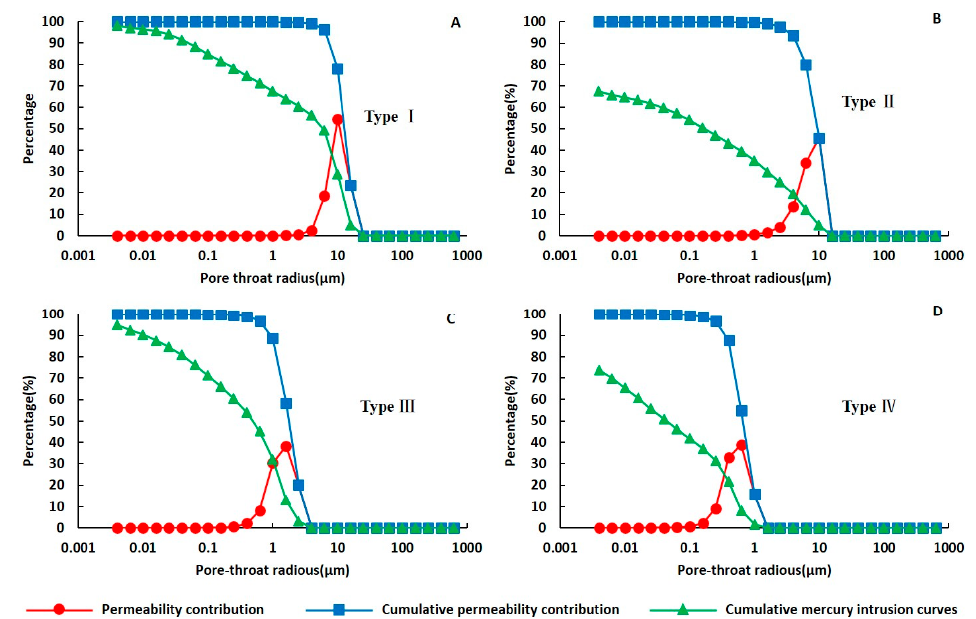
Figure 7. Permeability contributions of differently sized pore throats HPMI analysis ( A ) Sample 5; ( B ) Sample 1; ( C ) Sample 3; ( D ) Sample 2.